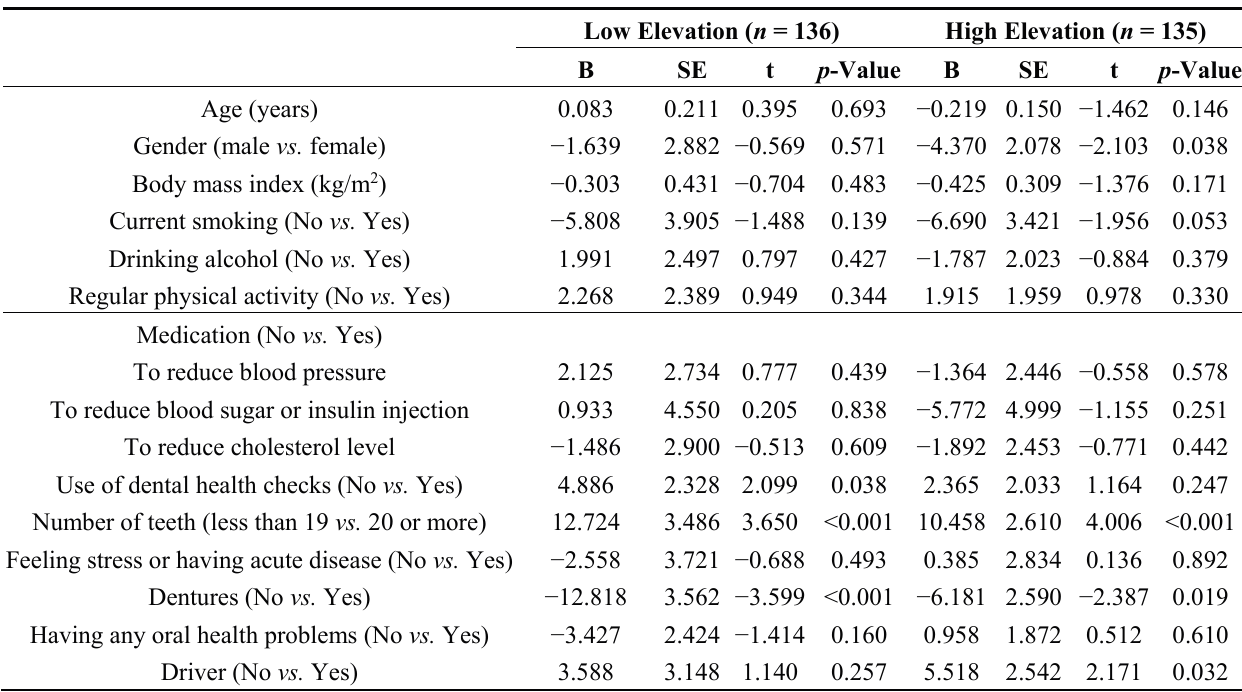
Table 3. Multivariable linear regression analysis with masticatory ability as dependent variable in Mizuho county.